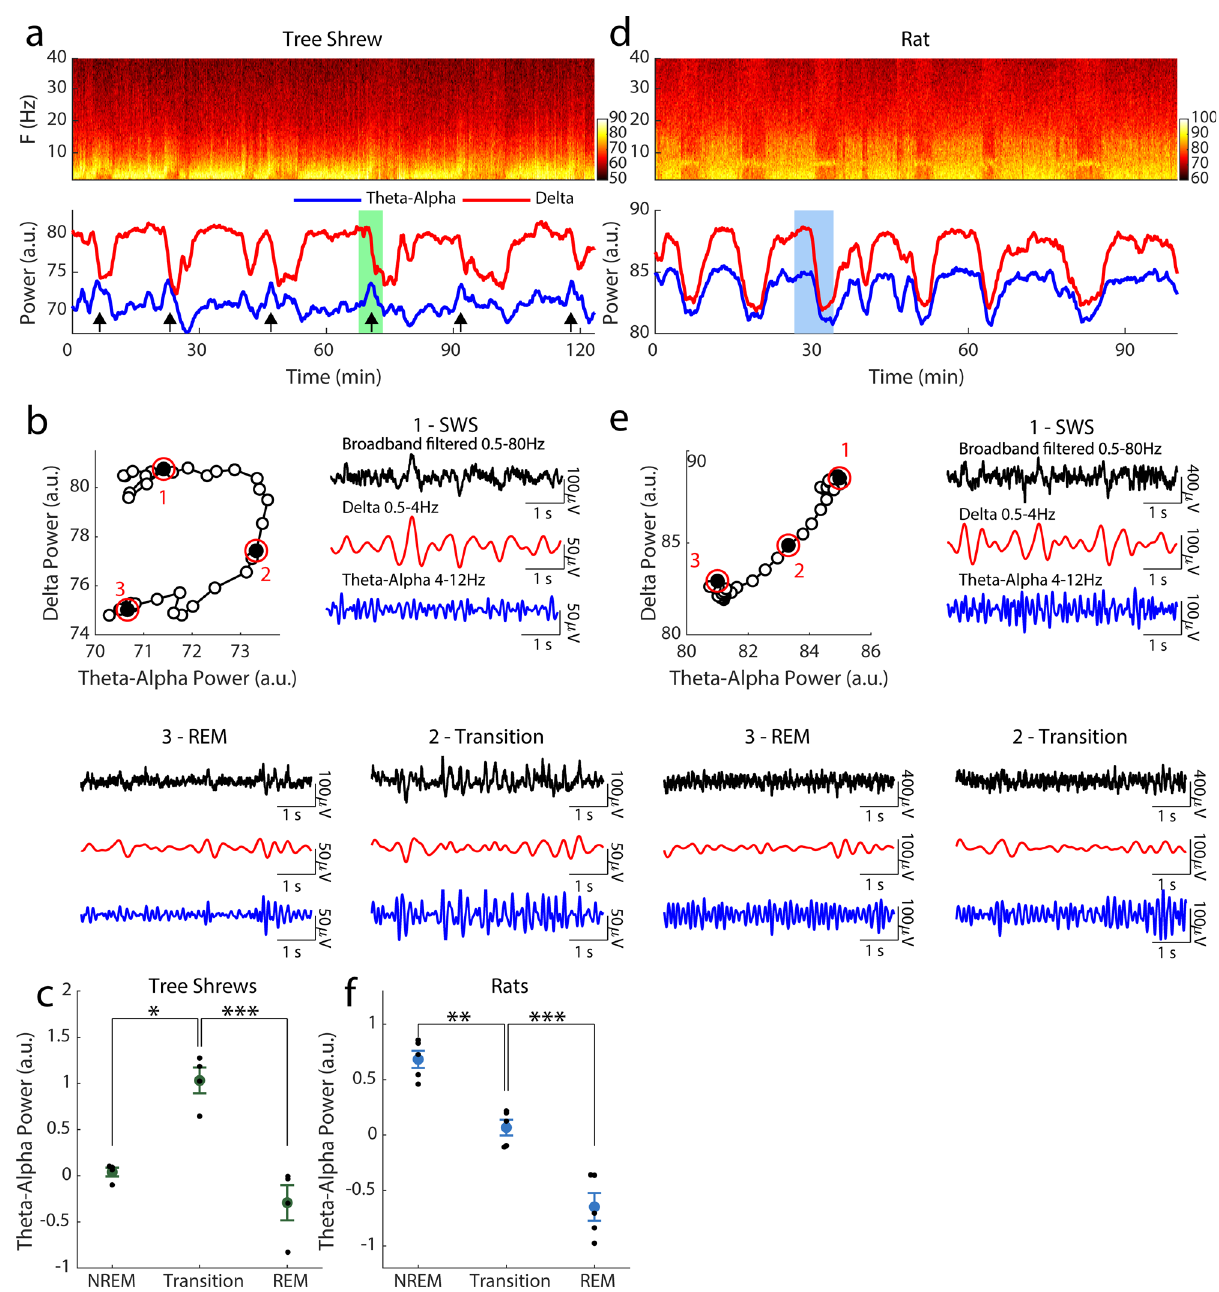
Fig. 1 Dynamics of the transition episodes in tree shrews and rats. Spectrograms of example segments of tree shrew ( a ) and rat ( d ) sleep, with the corresponding delta power, red (0.5 – 4 Hz) and theta-alpha power, blue, (4 – 12 Hz) shown below. Black arrows indicate periods of increased theta-alpha power accompanying NREM/REM transitions. Selected transitions for tree shrew and rats are shown in ( b ) and ( e ) respectively. Top level panels show delta vs. theta-alpha power for the sleep segments highlighted in ( a ) and ( d ). Circled epochs 1 – 2 are expanded in the surrounding numbered panels, showing the corresponding fi ltered LFP traces. Note that in the example rat delta and theta-alpha power decrease together while in the tree shrew an initial decline in delta power is accompanied by a transient increase at the theta-alpha band, see arrows in ( a ). Indeed this transient increase in theta-alpha power during transitions was signi fi cant for the population of tree shrews ( n = 4) as shown in ( c ), while theta-alpha signi fi cantly decreased during transitions in rats ( n = 5) as shown in ( f ), paired t -tests, * p < 0.05, ** p < 0.01, *** p < 0.001. Error bars re fl ect the standard error of the mean. Color bars re fl ect Fourier power in arbitrary